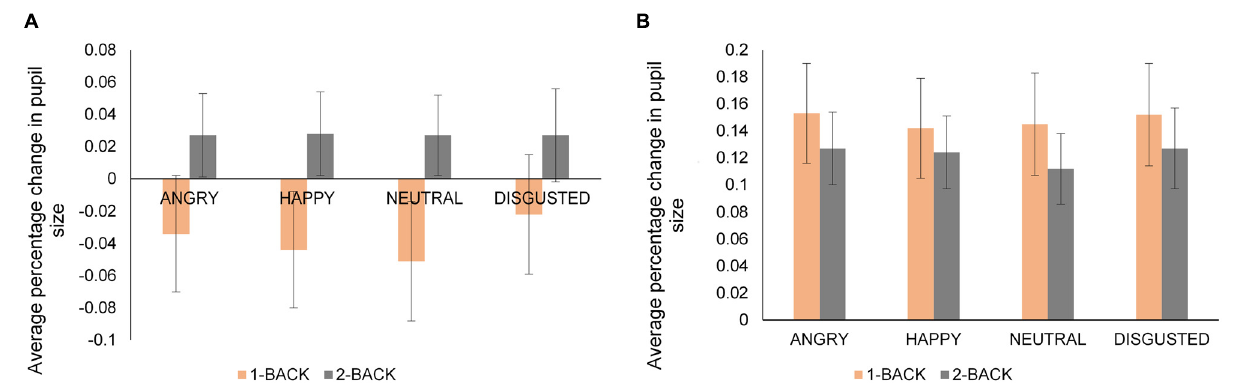
FIGURE 4 |Average percentage change in pupil size from a fixation-cross baseline for younger (A) and older (B) adults for angry, happy, neutral, and disgusted faces in 1-Back and 2-Back tasks. Error bars denote standard error. Note the different scale of the vertical axis for younger and older adults.